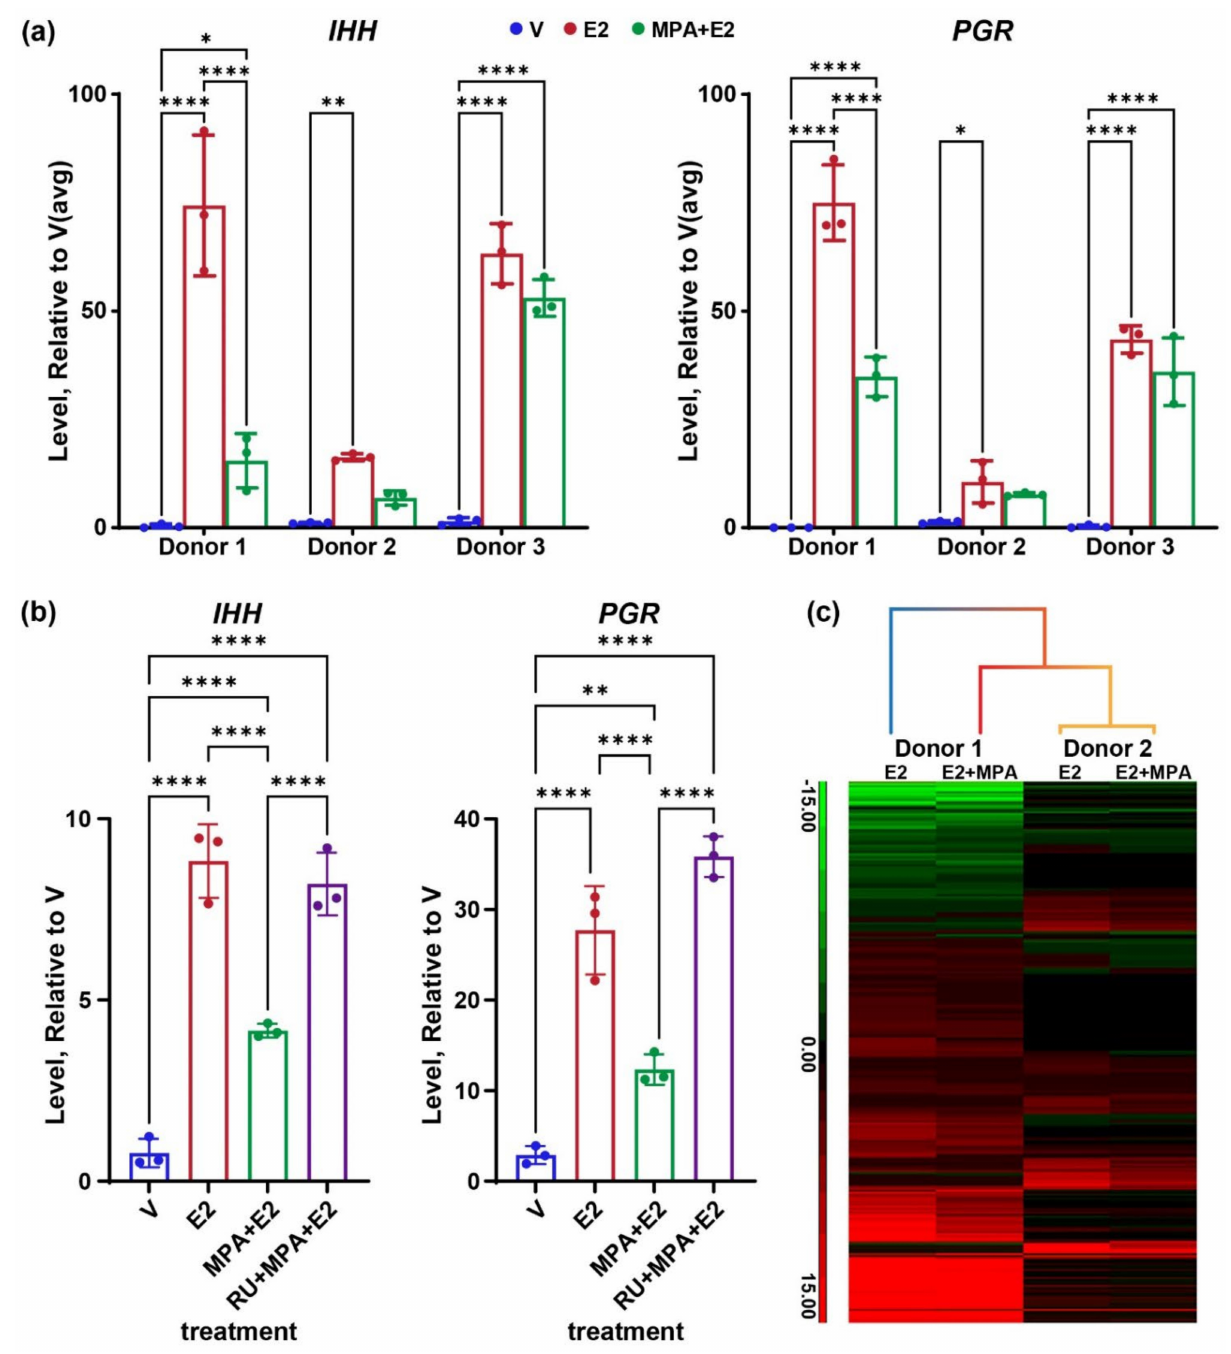
Figure 1. Progesterone attenuates estrogen-responsive genes. ( a ) RT-PCR for IHH or PGR from RNA after treatment of organoid isolated from 3 different donors with vehicle (V) estrogen (E2) or estrogen with medroxyprogesterone acetate (MPA+E2). *, **, **** p < 0.05, 0.01, and 0.0001, respectively, after one way ANOVA with uncorrected Fisher’s LSD test, n = 3 samples per group. ( b ) RT-PCR for IHH or PGR from RNA after treatment of organoid isolated from donor 2 with V, E2, MPA+E2, or RU486+MPA+E2. **, **** p < 0.01 and 0.0001, respectively after one way ANOVA with uncorrected Fisher’s LSD test, n = 3 samples per group. ( c ) Hierarchical cluster heatmap of E2 vs. V (E2) or E2+MPA vs. V (E2+MPA) differentially expressed genes (2-fold, FDR p -value < 0.05) of RNA from 2 different